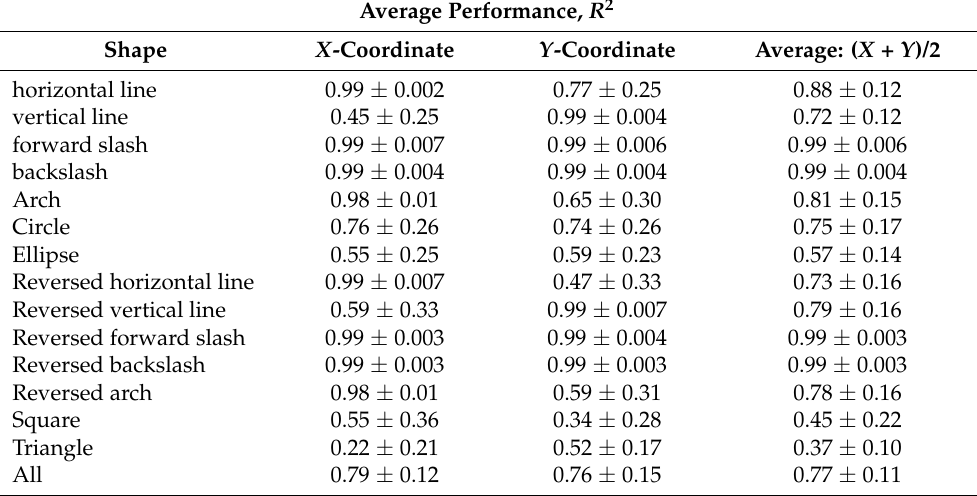
Figure 11. The randomly selected reconstructed drawing traces of between-group reconstruction by the KF. Table 8. Between-group reconstruction performance by the KF: the average accuracy of each shape across the five subjects.